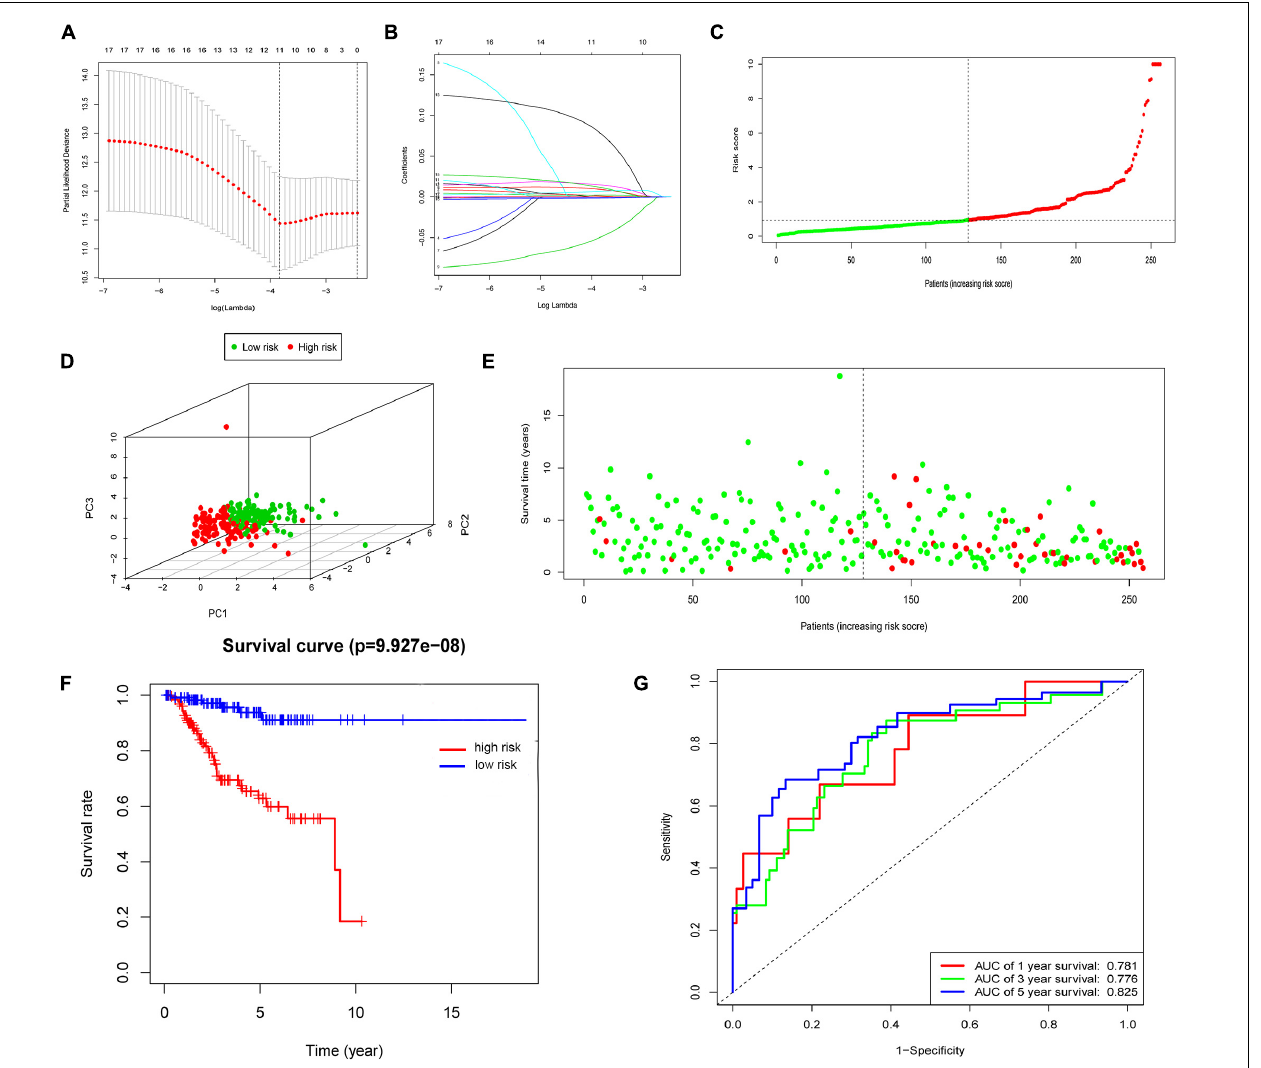
FIGURE 1 | Construction of the FRPS. (A) A cross-validation for tuning parameter selection in the LASSO model. (B) LASSO coefficient profiles of 17 prognostic immune-related genes. (C–E) The distribution of risk score, PCA and survival status in training set. (F) Kaplan-Meier survival curves of overall survival between high-risk and low-risk patients in training set. (G) 1-year, 3-year, and 5-year ROC curve of the predictive power of the FRPS in training set.